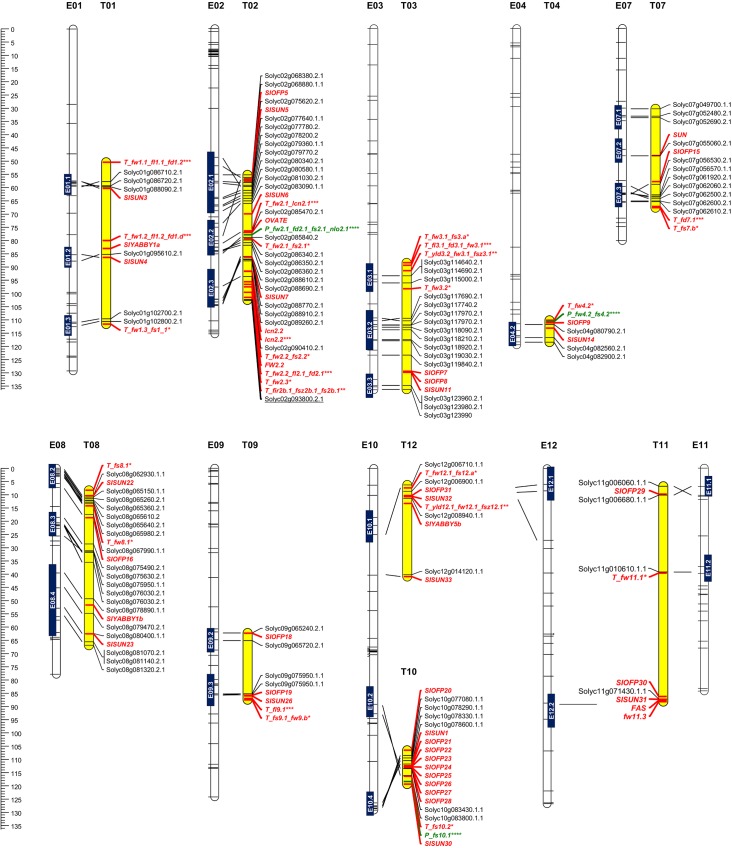
Synteny in the Solanaceae.Eggplant chromosomes are represented by white bars, and the site of QTL detected by GWA analysis is indicated. Tomato chromosomes are represented by yellow bars, along with the position of candidate genes (shown in red). Asterisks indicate orthologous QTL detected in tomato (* Grandillo et al. [30], ** Frary et al. [33], *** Lippman and Tanksley [31]) shown in red, and in pepper (**** Barchi et al. [39], Zygier et al. [38], Chaim et al. [37]) shown in green.